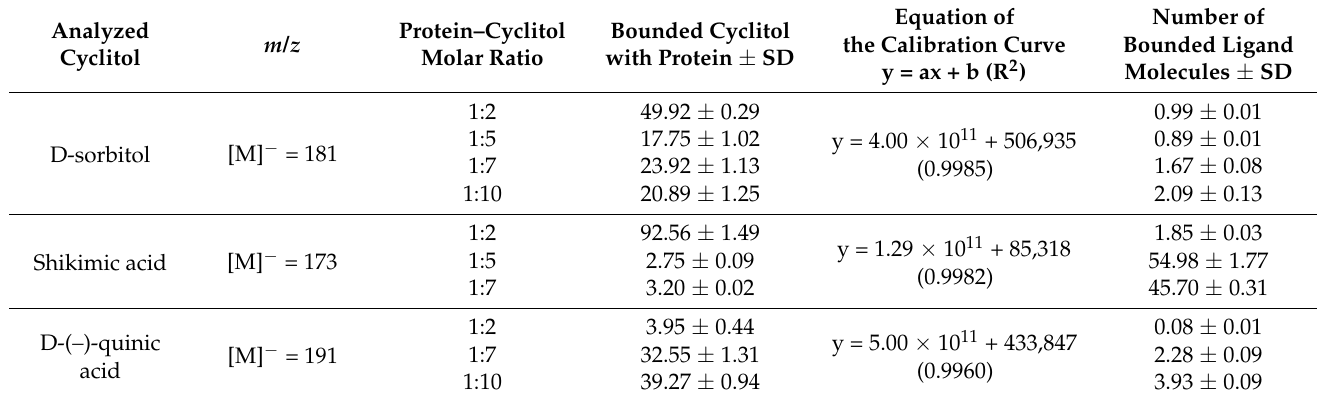
Table 3. Number of bounded cyclitol molecules based on the initial protein–cyclitol molar ratio calculated by the equation obtained from the calibration